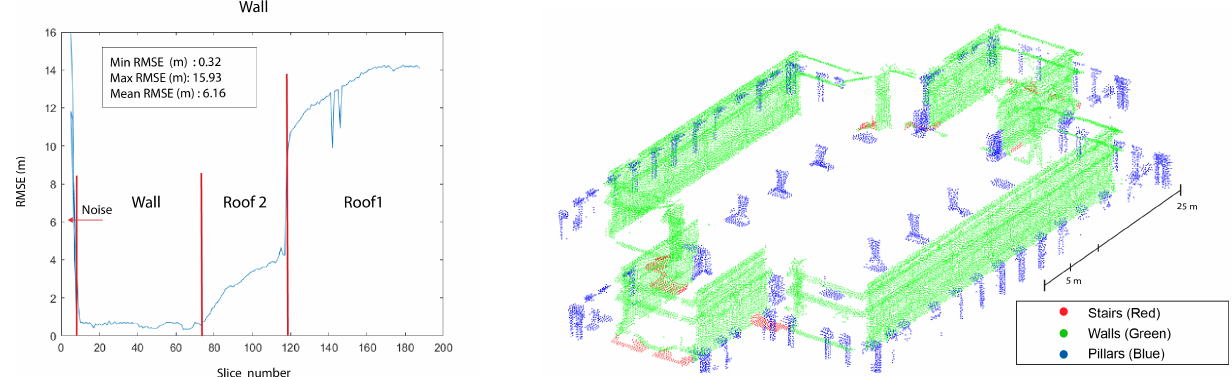
Figure 6. LEFT : Interval of interest for ” walls ” semantics — RIGHT : Classification results in 3 different classes